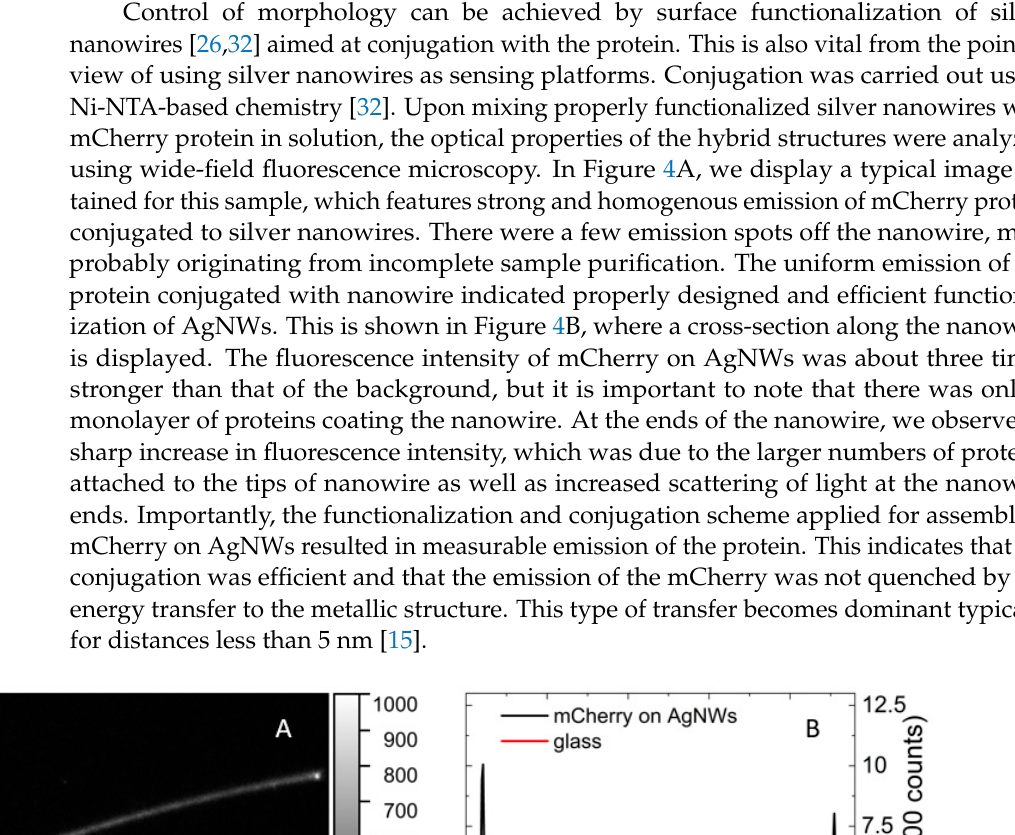
Figure 5. Fluorescence intensity decay measured for mCherry on glass (black line) and conjugated to AgNWs (red line). 3.3. Real-Time Fluorescence Imaging of His-Tag-Driven Conjugation The ability to enhance the optical response of the mCherry protein upon conjugation with silver nanowire prompted us to apply this scheme to monitor conjugation in real time using wide-field fluorescence imaging. First, a droplet of silver nanowires was deposited on a glass coverslip, and the positions of the nanowires were determined using the transmission mode of the microscope (Figure S3, Supplementary Materials). Then, acquisition of a film started; the snapshots taken at increased time intervals are shown in Figure 6. The first image proved that functionalized AgNWs themselves were